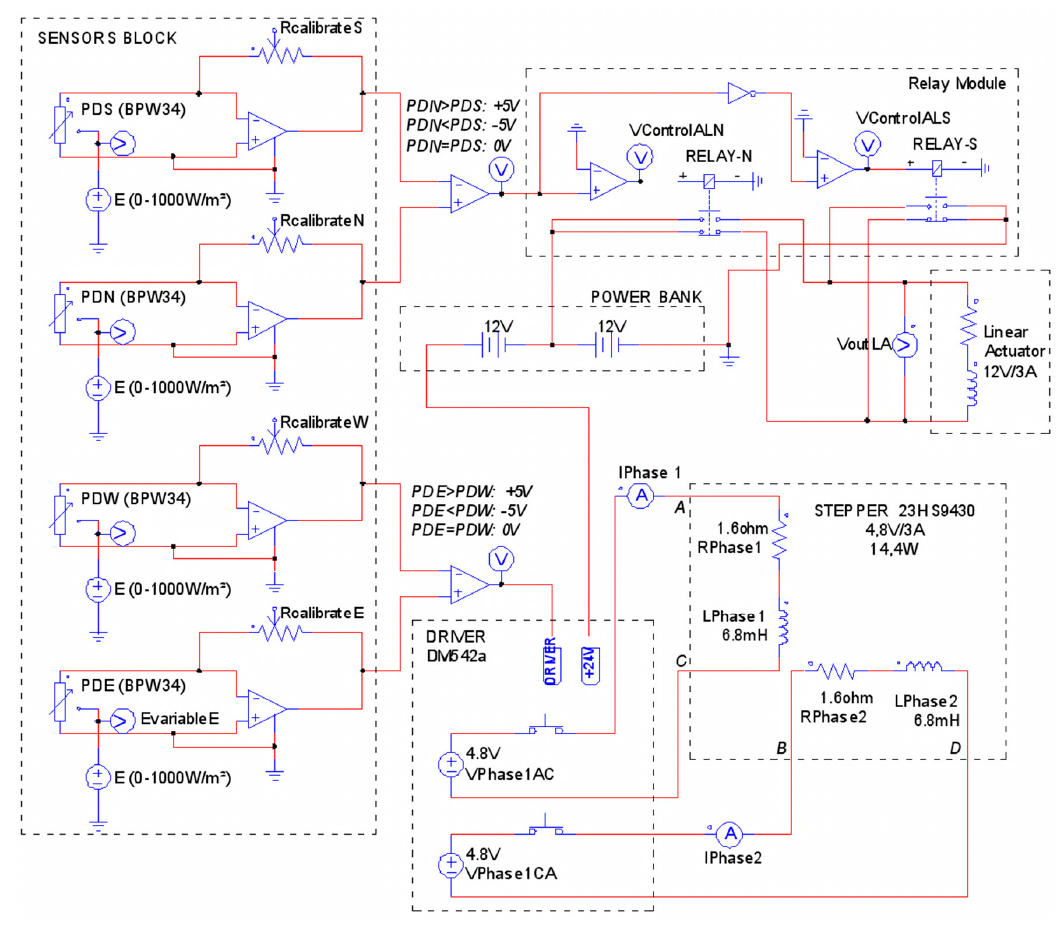
Figure 2. Scheme of simulated prototype.